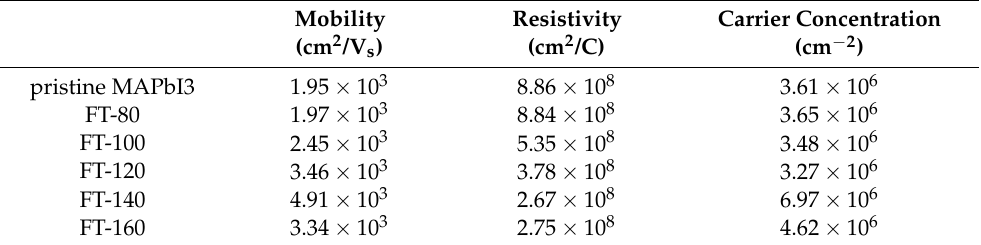
Table 1. The mobility, resistivity and carrier concentration of the control group and different filming